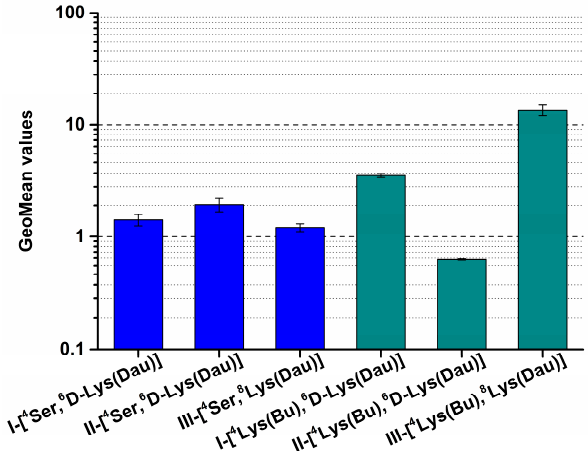
Figure 1. Cellular uptake of GnRH conjugates containing 4 Ser or 4 Lys(Bu) by HT-29 cells. Cellular uptake was studied at 10 − 4 M concentration and after 6 h of incubation. The dimensionless GeoMean (geometric mean channel) value refers to the relative fluorescence intensity. Two independent experiments were carried out by using two parallels, and representative data are shown. Data shown represent the mean ± SD of two parallels.